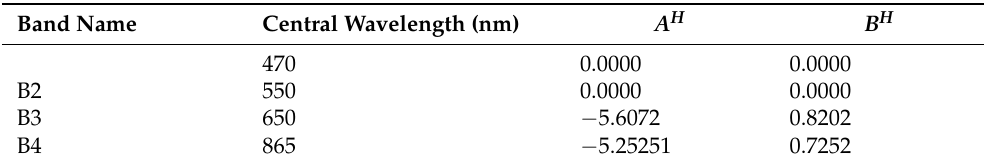
Table 2. Water vapor absorption coefficients in the first four bands of the MERSI sensor of the meteorological satellite